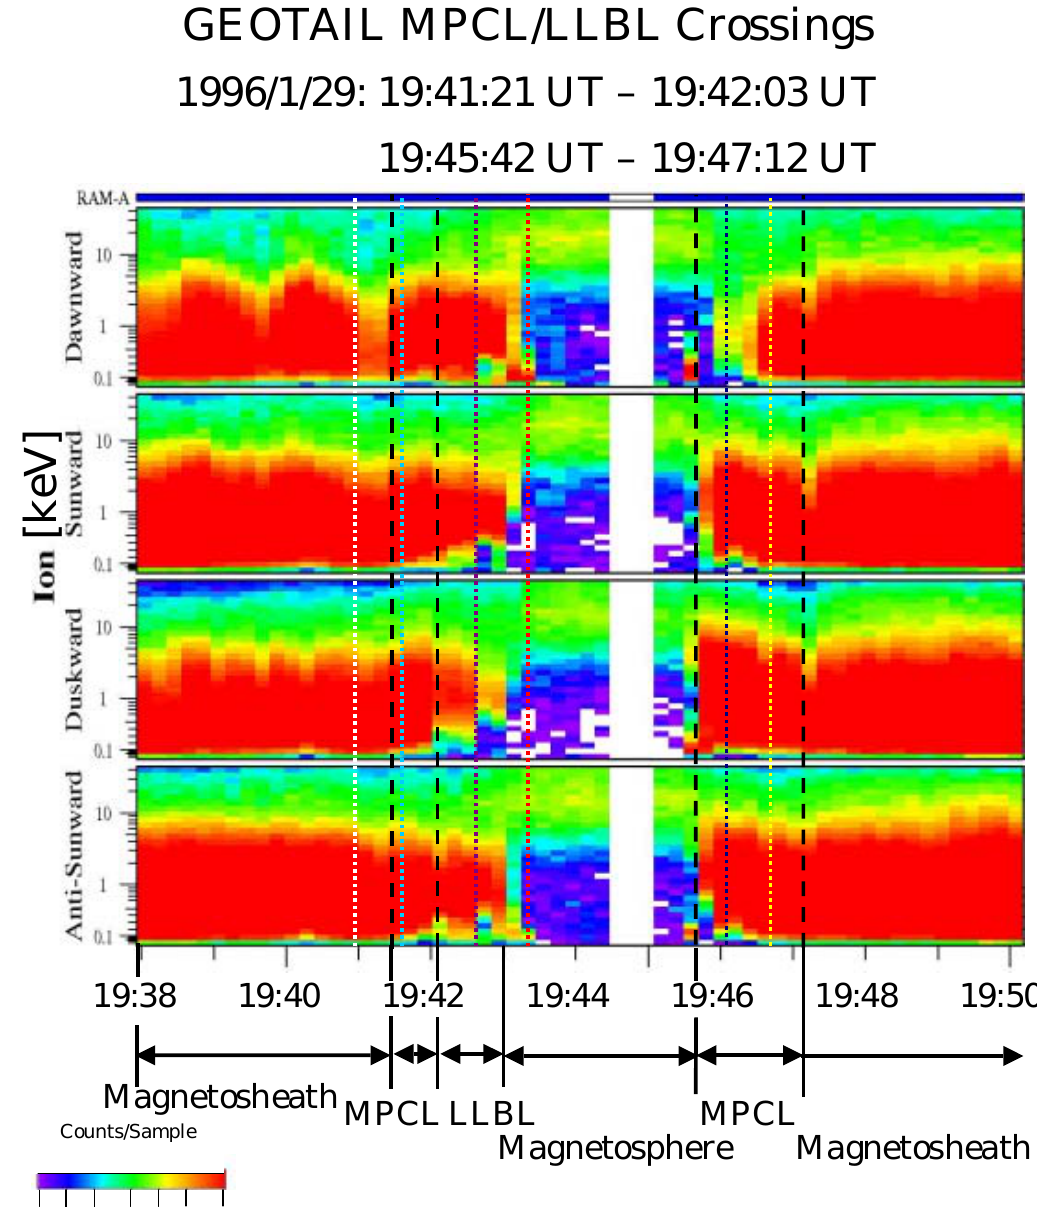
Fig. 5. Ion energy-time spectrograms for four directions (dawnward, sunward, duskward and antisunward directions) of two MPCLs and LLBL crossings during the interval from 19:38:00 UT to 19:50:00 UT on 29 January 1996. The ion population from 5.0 counts/sample to 500 counts/sample is shown with the lower color bar. Two MPCL crossings are bracketed by broken lines.